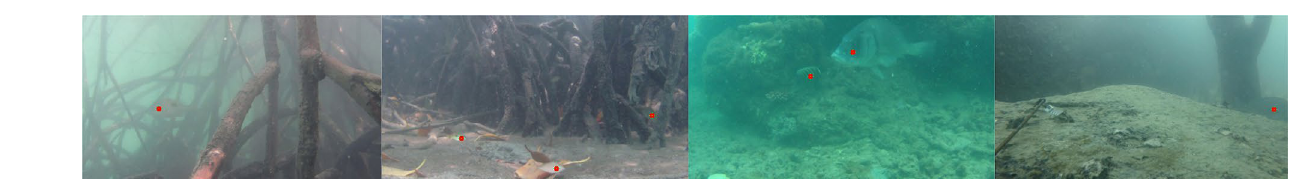
Figure 1. Different labeling schemes. Point-level supervision places a single point on each fish body, whereas other non-precise labelling methods such as scribble-level and bounding box annotations provide more labelling details. The full supervision labelling method on the far right provides full label masks.